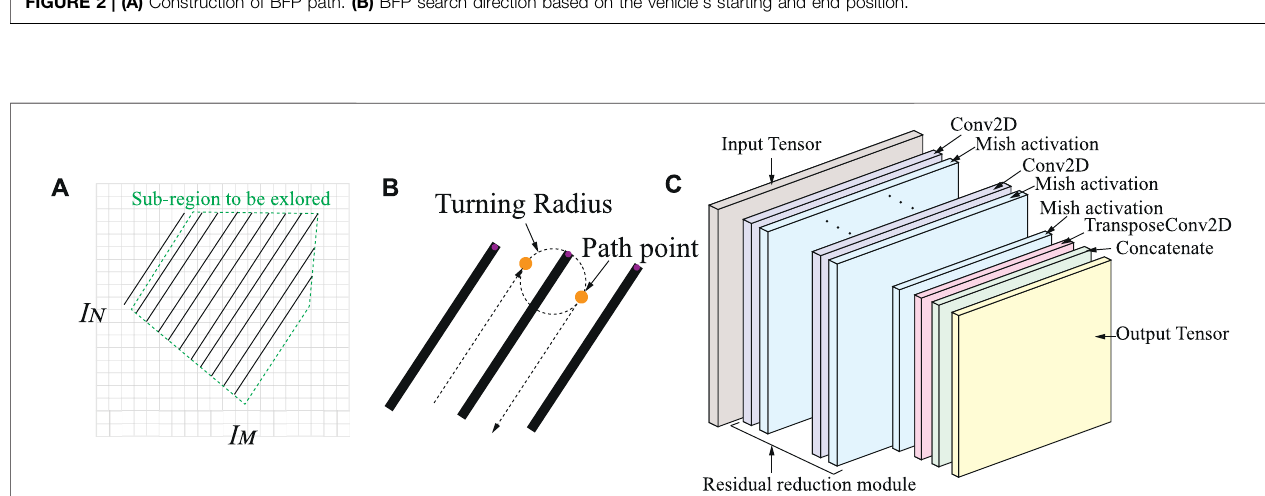
FIGURE3|(A) Theoccupancygridmapoftheworkspace. (B) ThecomputationoftheCCPPpathwaypointlocationbasedonvehicleturningradius. (C) Overview of the deep learning architecture.